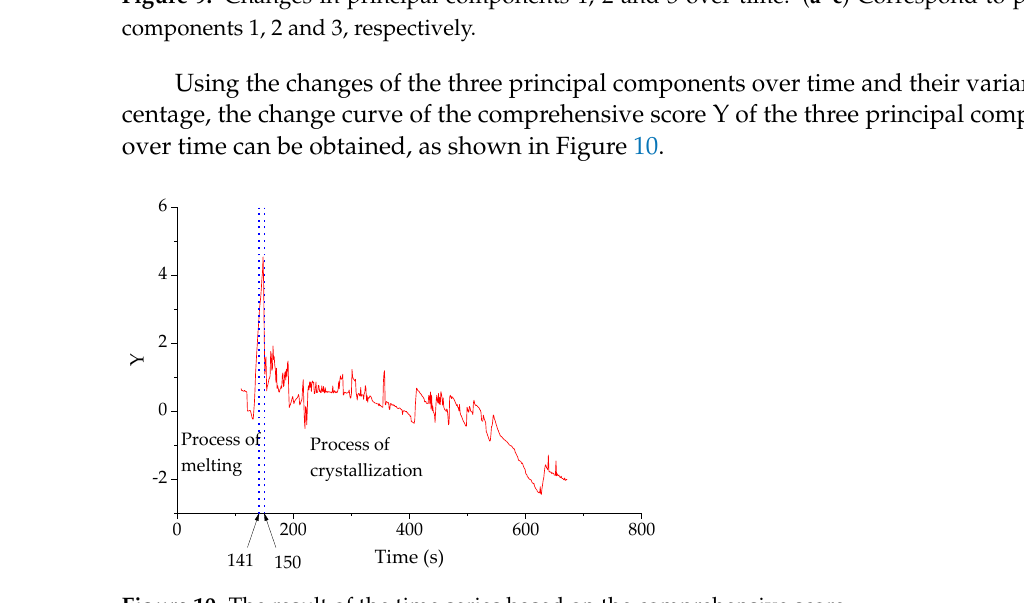
Figure 10. The result of the time series based on the comprehensive